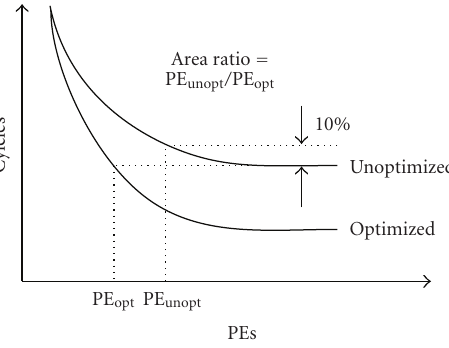
Figure 16: Clustering , Placement , Fanout-Routing, and Fine- Grained Synchronization ( ibm01 ).